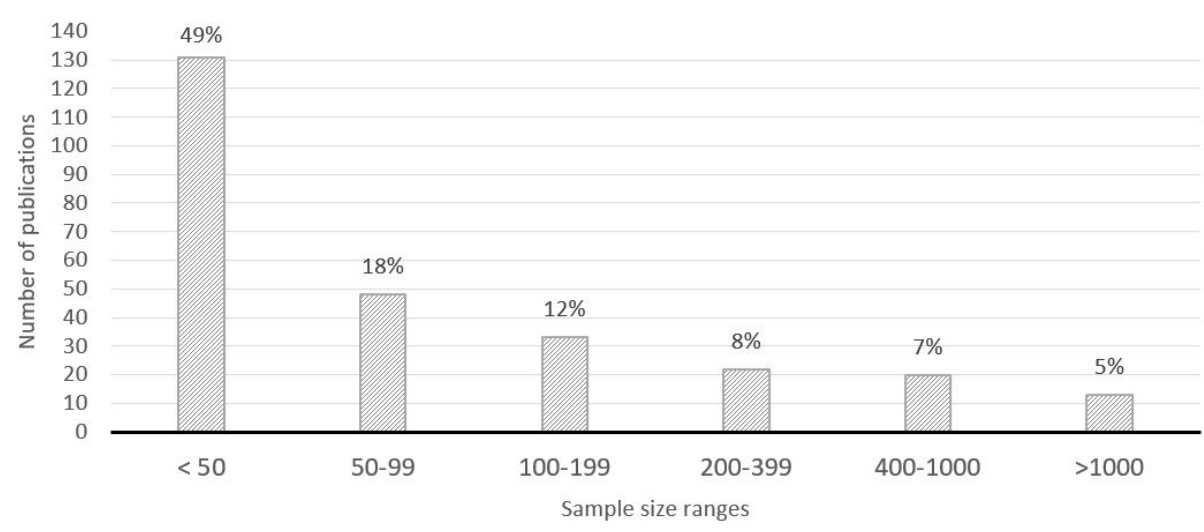
Figure 10. Types of sample sizes used in the studies examined ( n = 272).